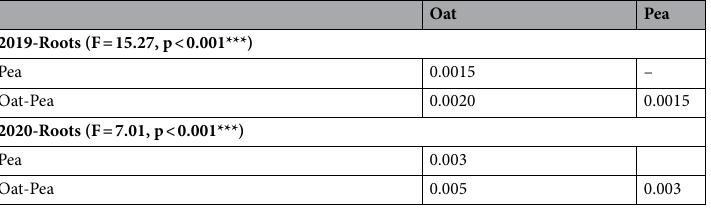
Table 2. Pairwise community composition comparison between cropping options in root samples based on PERMANOVA. p value adjusted by false discovery rate (FDR). Significance codes: p < 0.05, *; p < 0.01, **; p < 0.001,